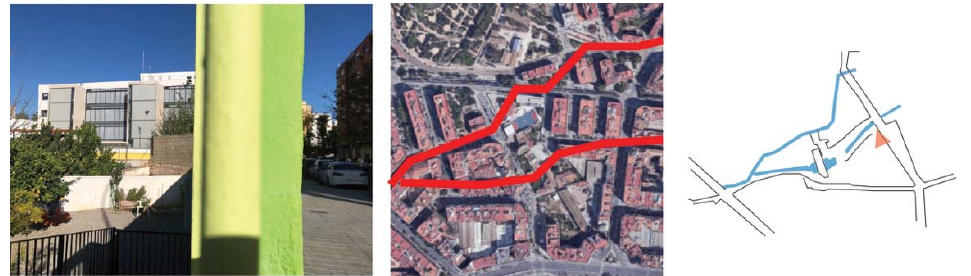
Figure 15. The inheritance of the irrigation canals in urban spatial structure and satellite images showing the type of land configuration in relationship with canal layout. (1) The inheritance located between urbanized area and cultivation area. (2) The inheritance located in urbanized area. (3) The inheritance located between building block and urban green. (4) The inheritance located in the historic settlement.